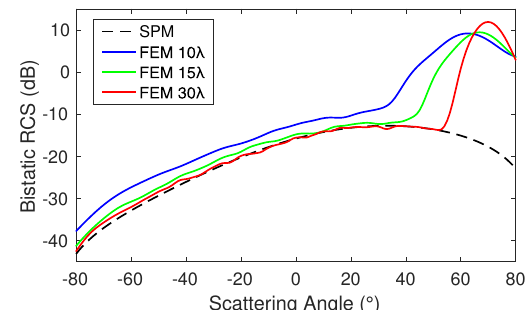
Figure 6. Bistatic RCS for the HH polarization simulated by the SPM and the FEM under different surface